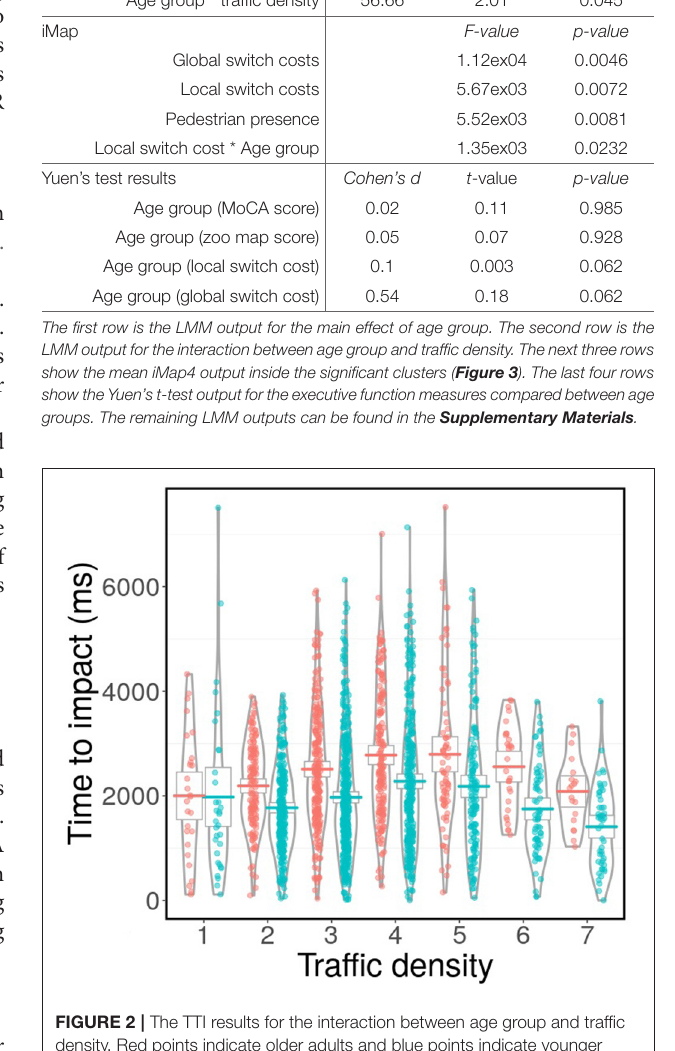
( Figure 2 ). We found no significant difference between older and younger adults on time to impact ( Supplementary Figure 4 and Supplementary Table 1 ). A Bayesian LMM did not indicate